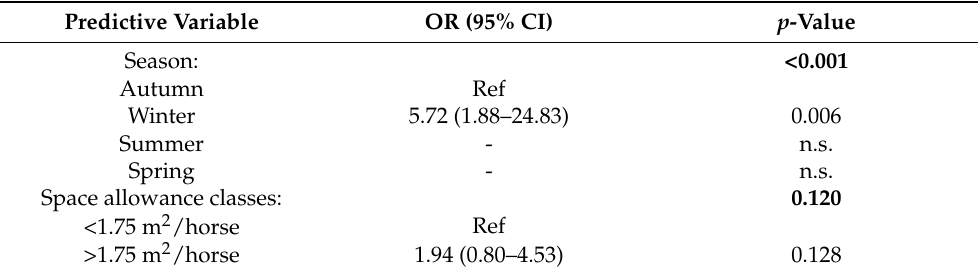
Table 13. Final multiple regression model for the dummy dependent variable of presence/absence of diarrhea and abnormal feces 24 h after unloading. Data are presented as odds ratio (OR), confidence interval (95% CI), and p